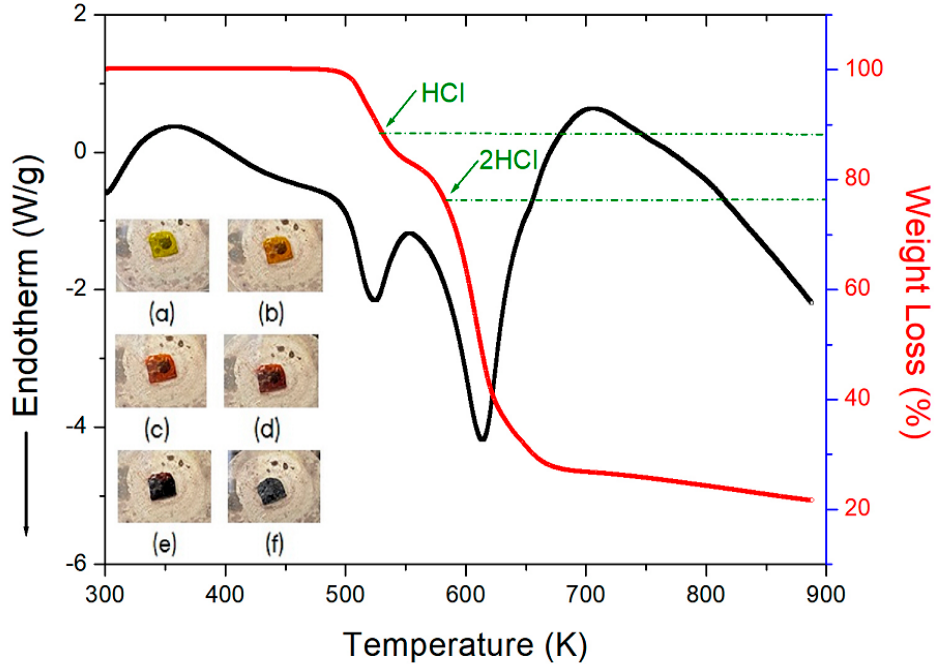
Figure 2. TGA and DTA curves of [NH 3 (CH 2 ) 5 NH 3 ]CuCl 4 (inset: changes in the crystal at the following temperatures: ( a ) 300 K, ( b ) 330 K, ( c ) 390 K, ( d ) 430 K, ( e ) 490 K, and ( f ) 540 K).